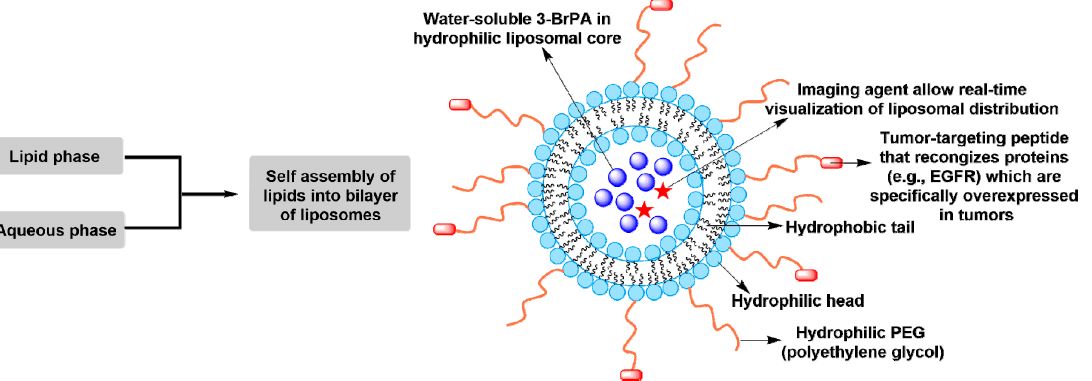
Figure 6. Stable liposomal nanoparticle formulation for selectively delivering 3-BrPA to tumors.